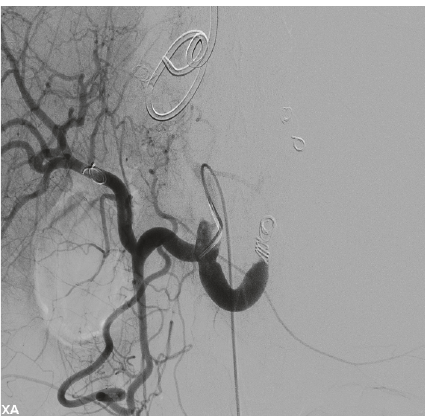
Figure 5: Showing coil embolization of splenic artery.